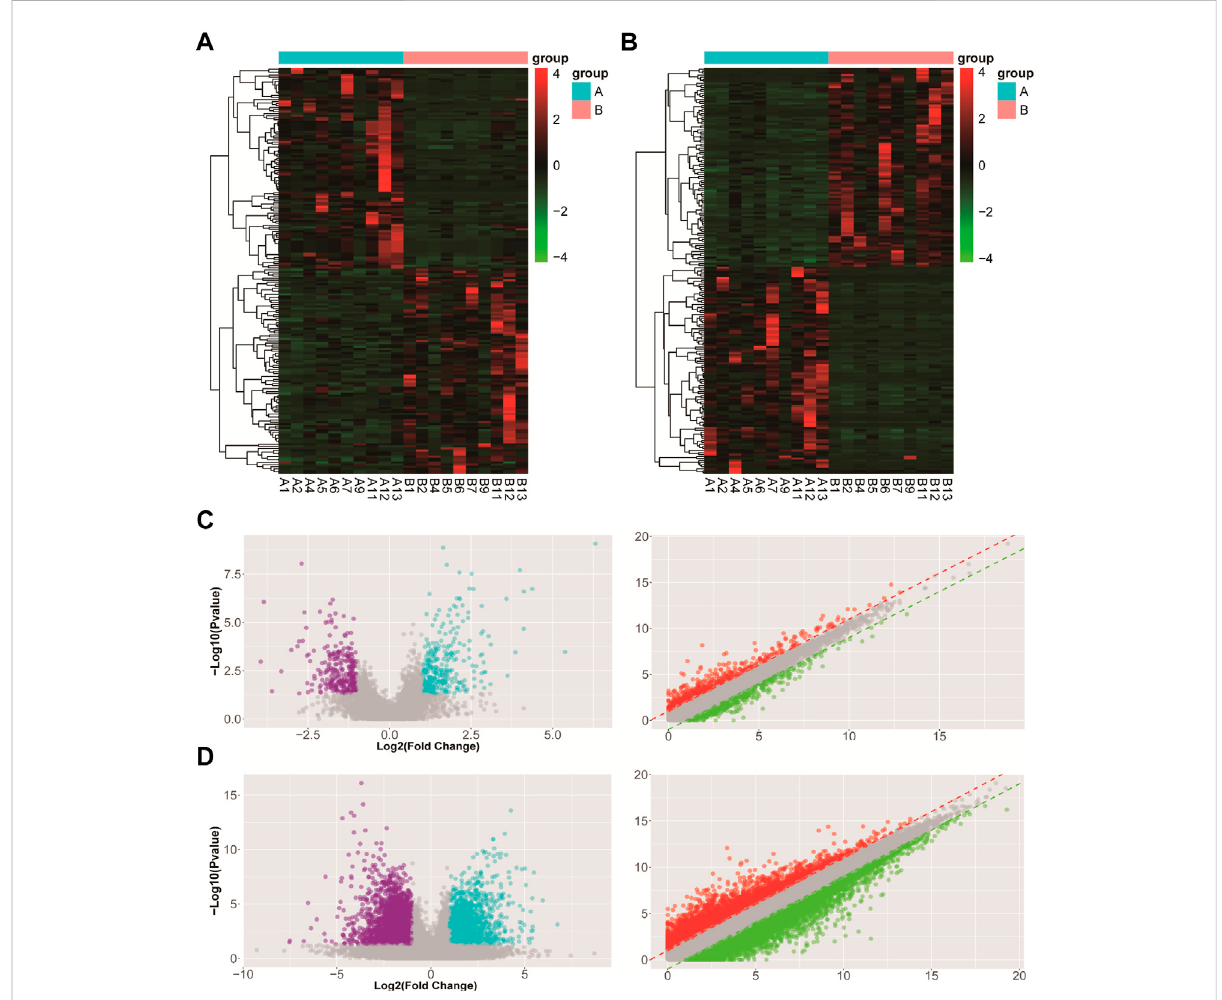
FIGURE 1 DElncRNA and DEmRNA expression patterns in uterine leiomyoma tissues are related to those in surrounding normal myometrial tissues. (A) Hierarchical cluster analysis of all differentially expressed DElncRNAs. (B) Hierarchical cluster analysis of all differentially expressed DEmRNAs; each column represents a sample, and each row represents a lncRNA and mRNA. The color scale indicates relative expression: upregulation (red) and downregulation(blue).Arepresentstheuterineleiomyomatissuegroup,andBrepresentsthesurroundingnormalmyometrialtissuegroup. (C) Volcano and scatter plots demonstrate differential expression of DElncRNAs between two different conditions. (D) Volcano and scatter plots demonstrate differential expression of DEmRNAs between two different conditions; red points indicate upregulated expression, while green points indicate downregulated expression. The values plotted on the X and Y axes are the averaged normalized signal values of each group (log2 scaled). FC ≥ 2 and p ≤ 0.05 were regarded as the differentially expressed DElncRNAs and